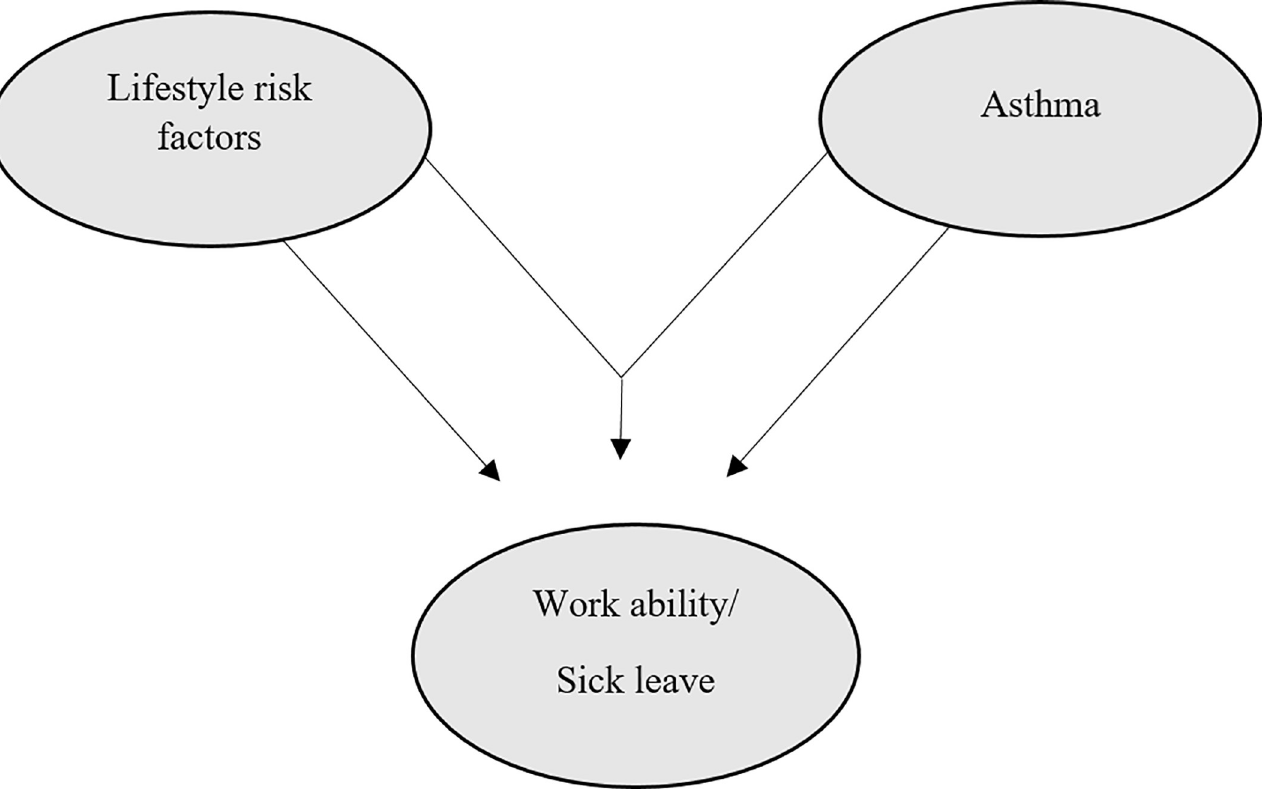
Fig 2. Hypothesized interaction of lifestyle risk factors and asthma on sick leave/work ability. Figure is inspired by Tonnon et al [33].